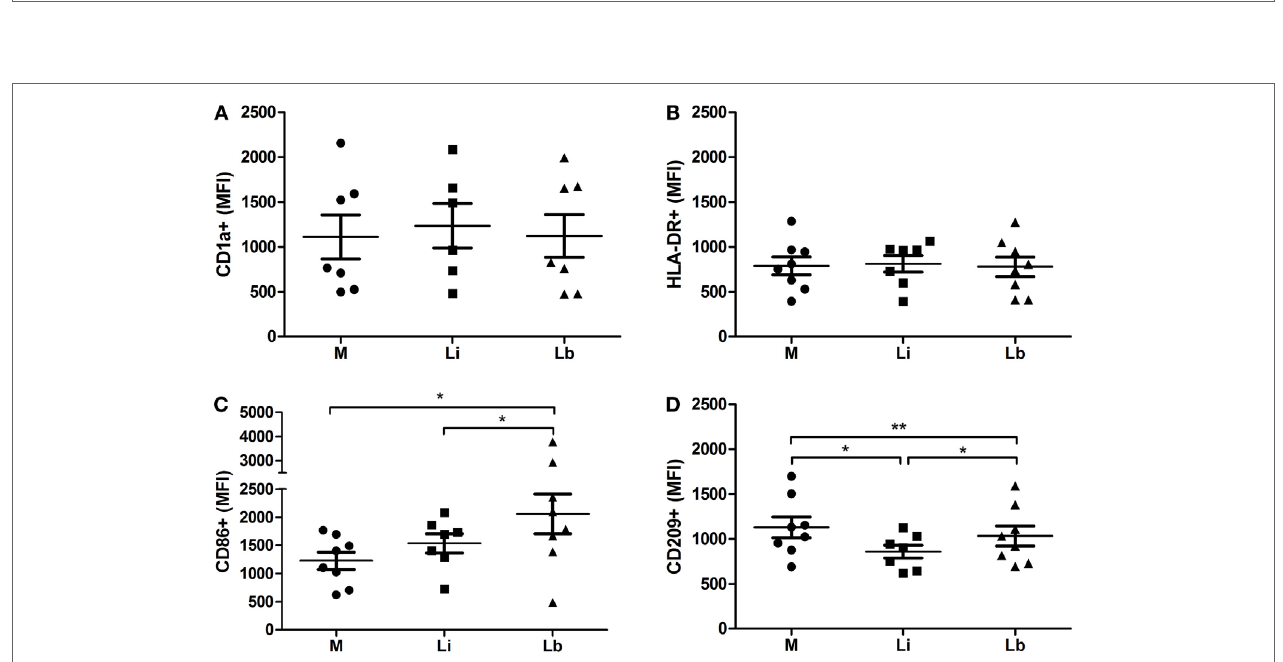
FigUre 4 | L. braziliensis- exposed Dcs increase the mean of fluorescence intensity (MFi) of cD86 and decrease cD209 – flow cytometry analyzes of the MFi in immature Dcs differentiated from human monocytes with cytokine-conditioned media (M) or conditioned media in the presence of viable L. infantum (li) or L. braziliensis (lb) . CD1a (a) , HLA-DR (B) , CD86 (c) , and CD209 (D) . Median ± SD. Each point represents one donor. * p < 0.05, ** p < 0.01.